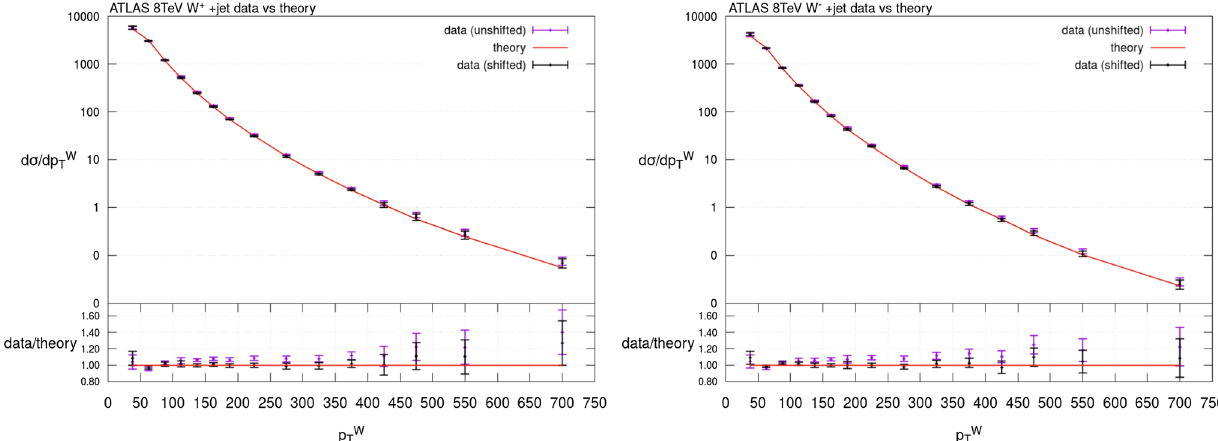
Fig. 10 Data vs. MSHT20 NNLO theory for the ATLAS 8 TeV W ± + jets data with W + ( W − ) in the left (right) plots. The purple represents the unshifted data, the black the data after shifting via correlated and